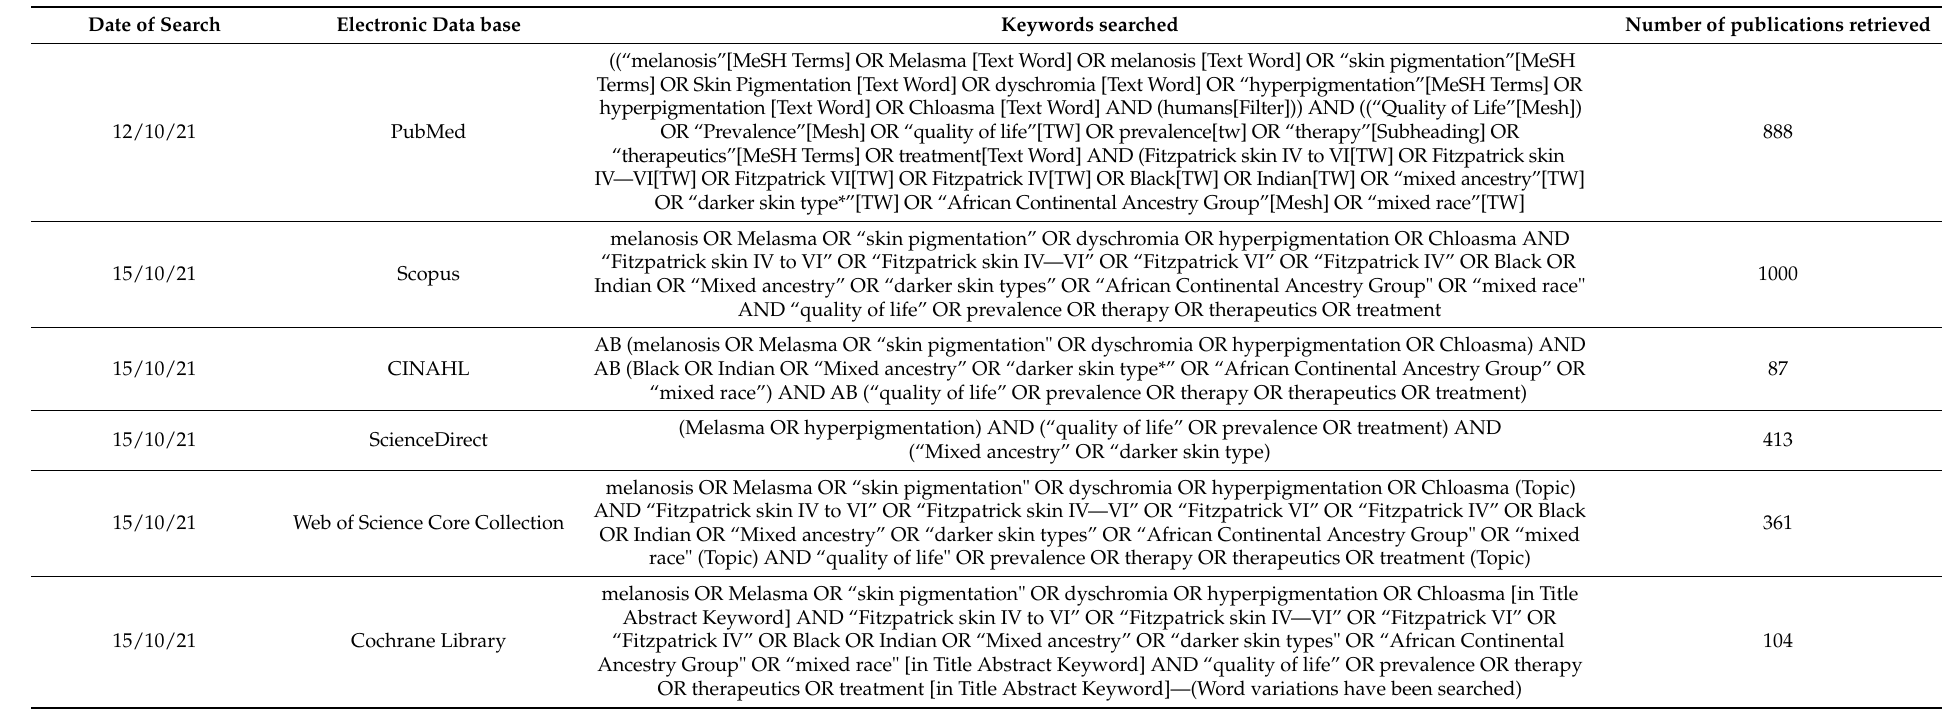
Table 2. Results from searched data